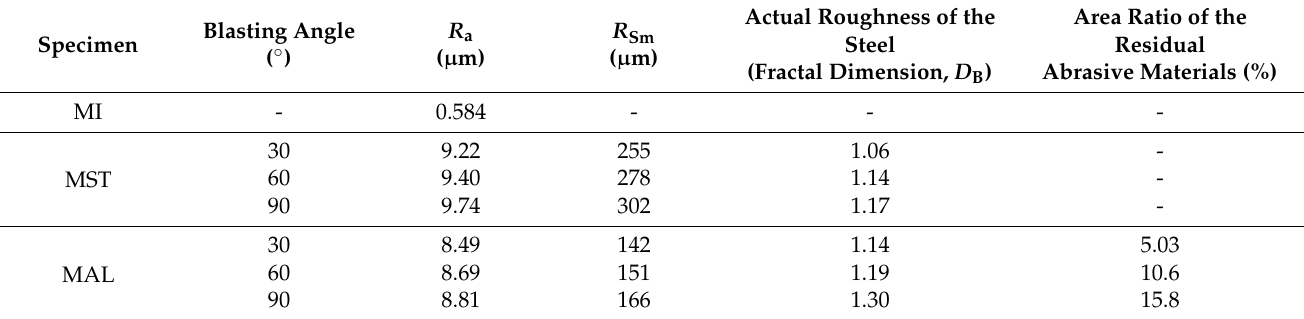
Table 5. The results of surface roughness according to blasting